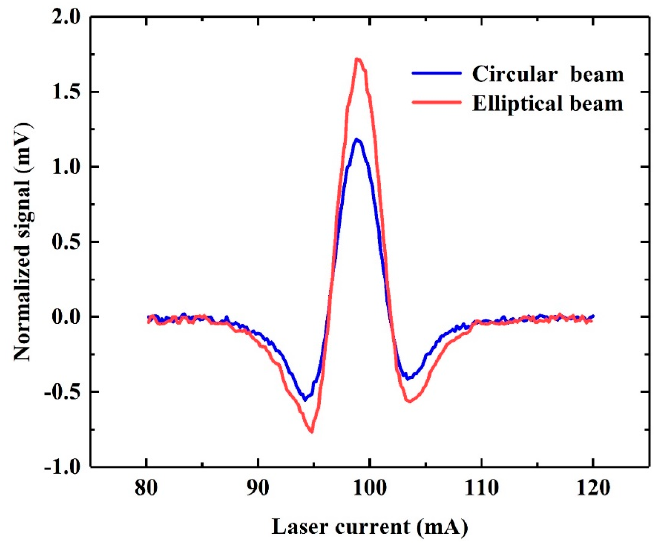
Figure 7. The comparison of normalized signal between the circular beam and the elliptical beam at atmospheric pressure.